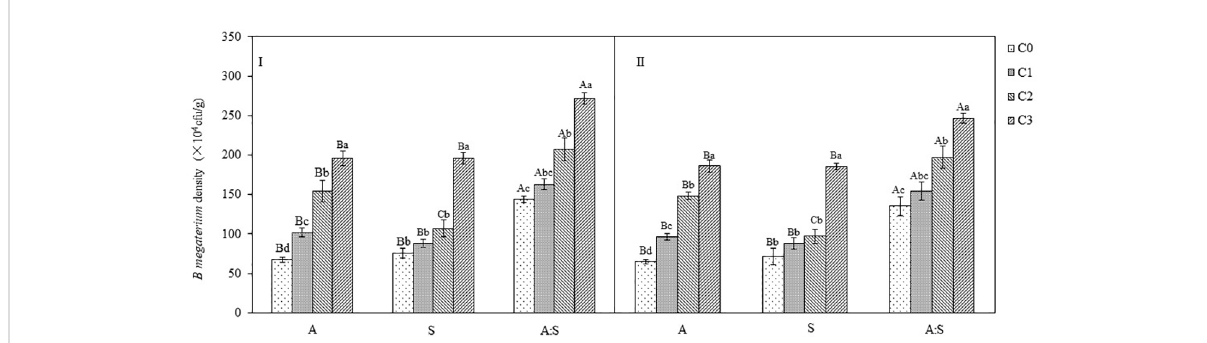
FIGURE 7 Effects of different concentration of B megaterium from the rhizosphere soil of A artemisiifolia (I) and S. viridis (II) on B megaterium density. C0, control; C1: 5×10 8 cfu/mL of B. megaterium ; C2: 15×10 8 cfu/mLof B. megaterium ; C3: 30×10 8 cfu/mL of B. megaterium . Different uppercase letters indicate signi fi cant differences between in the mixture and in the monoculture treatments at P <0.05. Different lowercase letters indicate signi fi cant differences among different concentrations of B megaterium at P <0.05. Error bars represent ±SD of mean( n